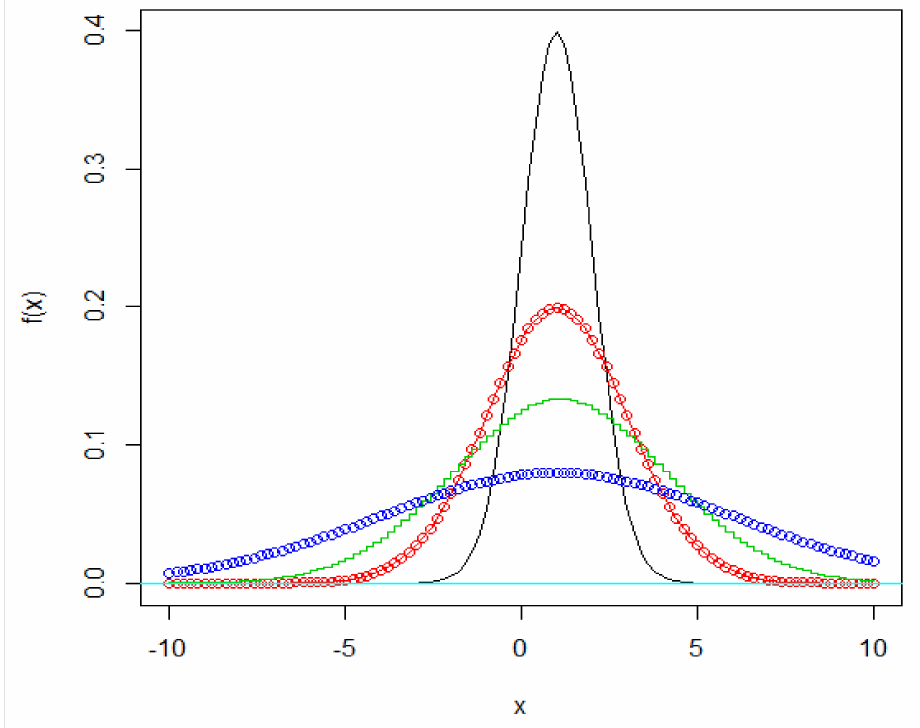
Figure 1. The PDF of the distribution normal ( µ , σ 2 ) for different values of CV (black: CV = 1; red: CV = 2; green: CV = 3; blue: CV =